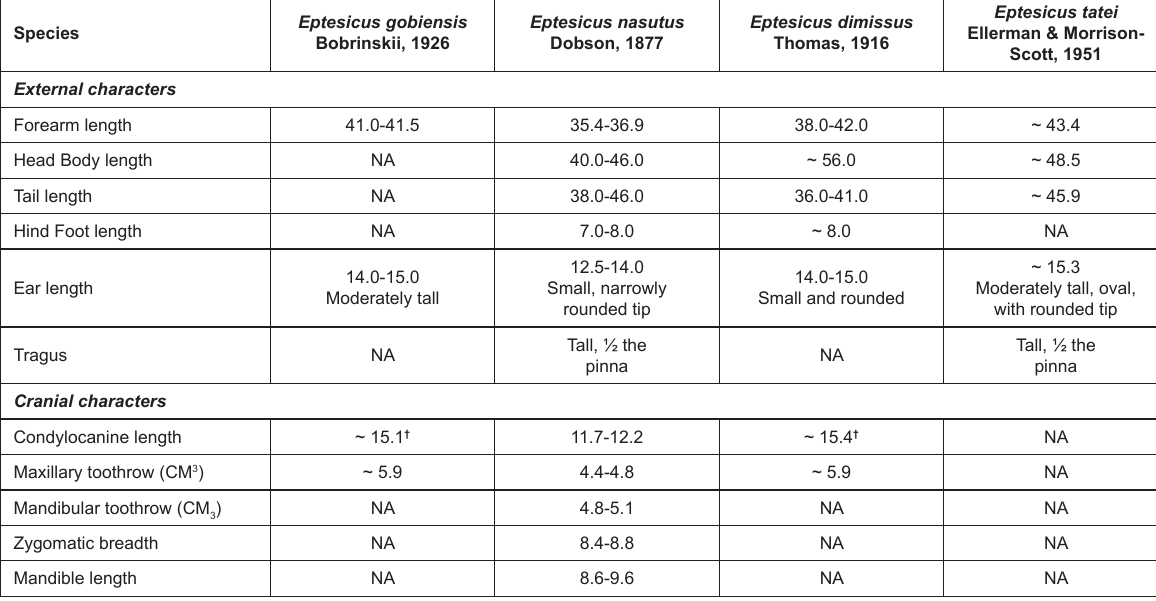
Table 7.6 (Contd..). Diagnostic morphological characters of the species belonging to the genus Eptesicus present in South